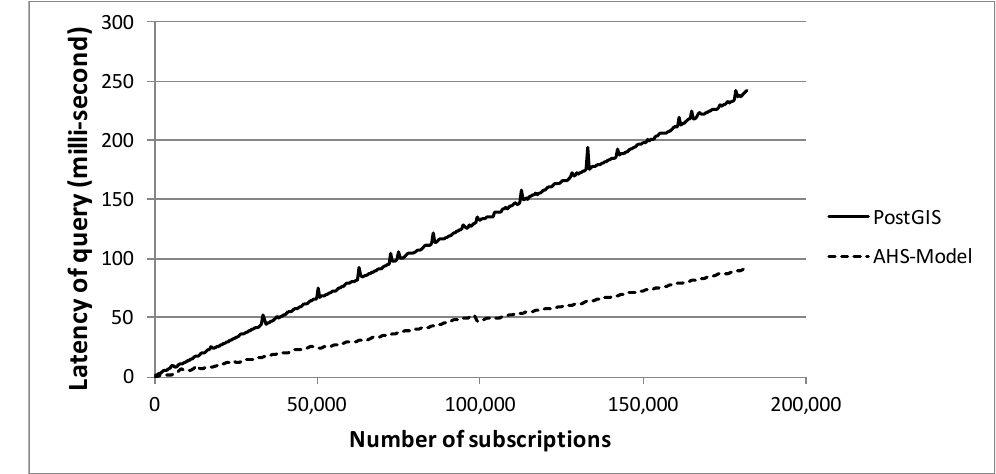
Figure 4. The AHS model query latency on different number of subscriptions.